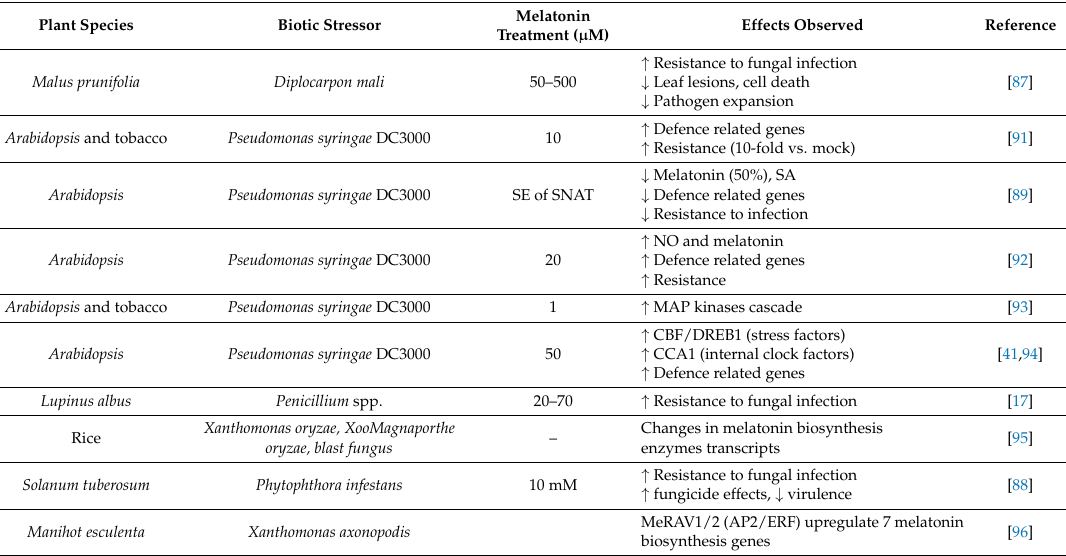
Table 4. Effects of melatonin in biotic stress responses.